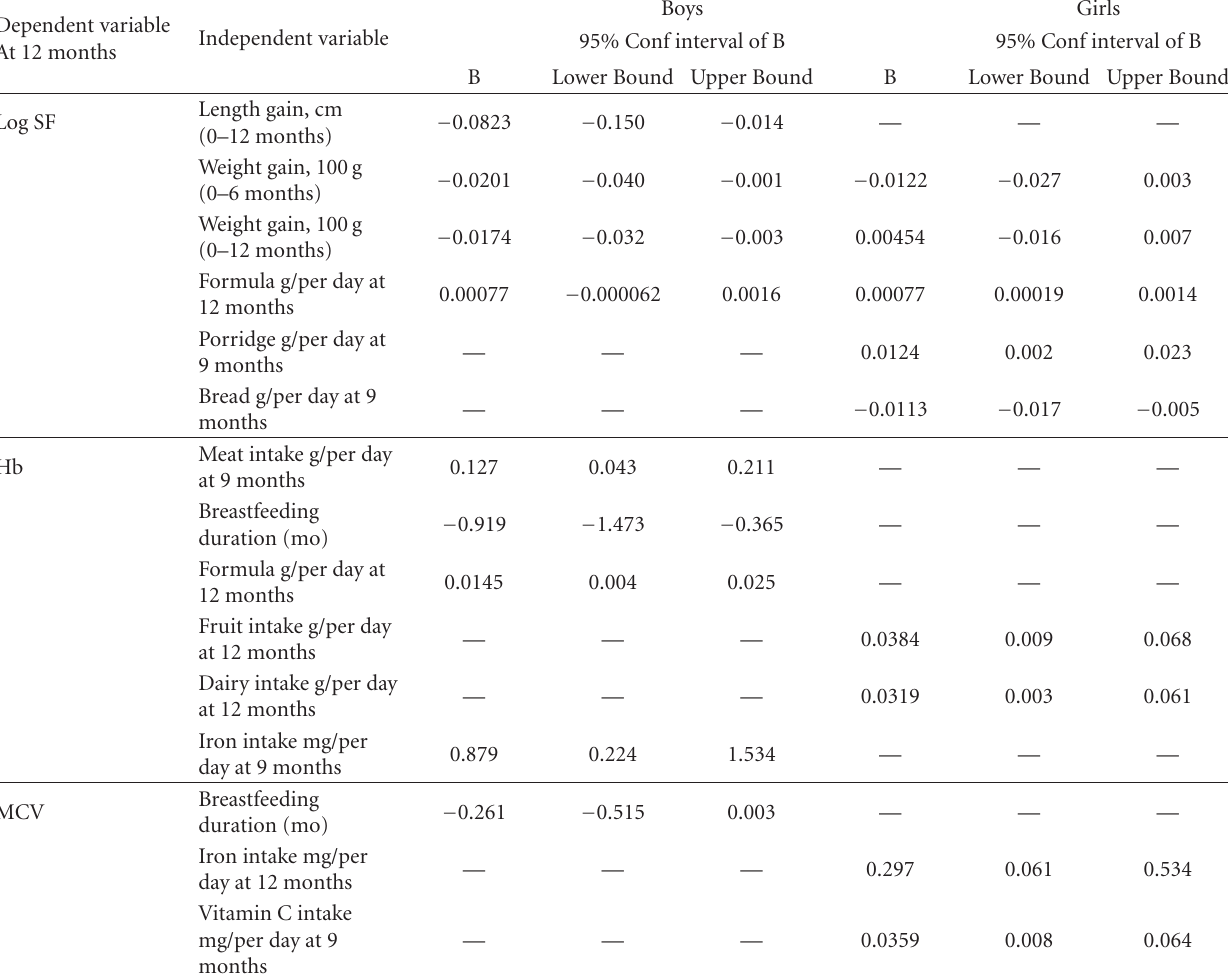
Table 4: Multiple regression analysis of weight growth and food factors influencing change in iron status